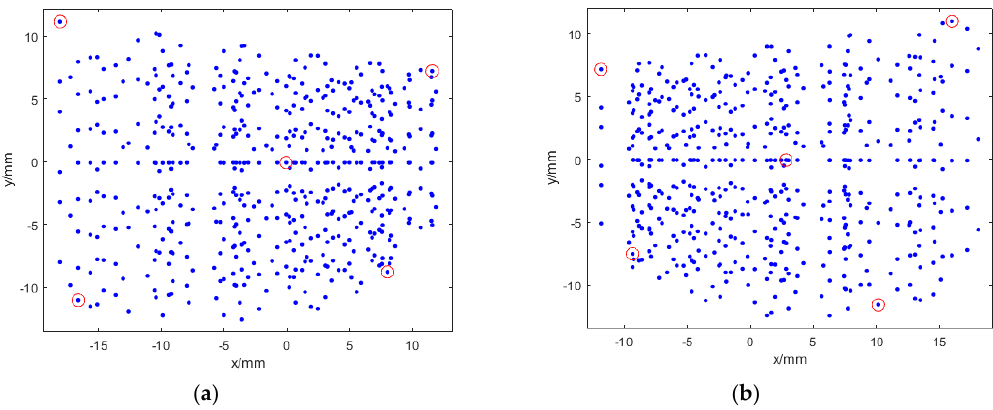
Figure 2. All the 2D RRTs centroids (blue dots) and the selected five correspondences (red circle) for relative orientation. ( a ) RRT points of the left camera; ( b ) RRT points of the right camera.